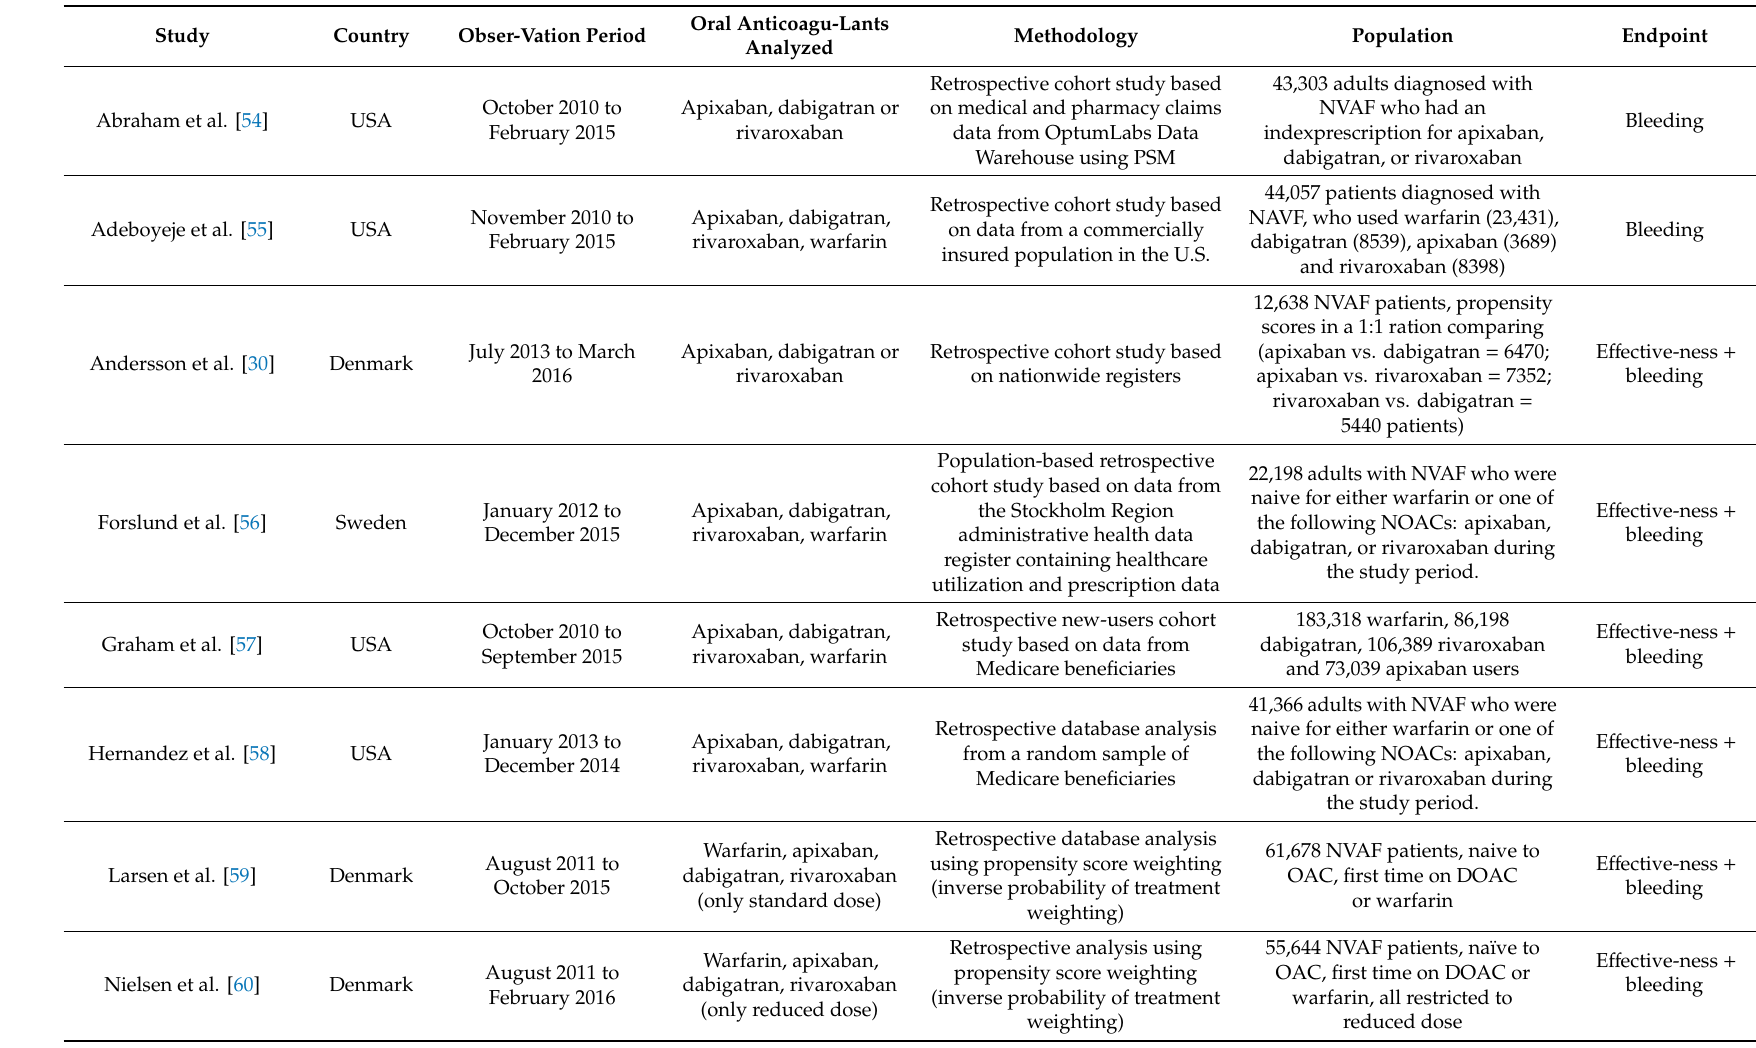
Table 3. Real-world studies that analyzed NOACs-related gastrointestinal